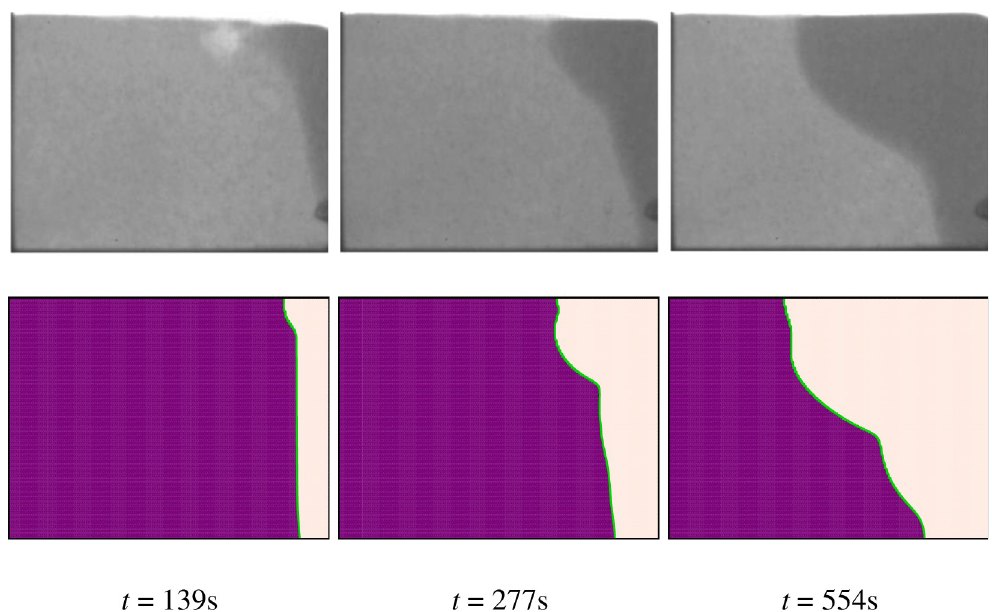
Fig 5. The comparison of experimental and numerical results: First row experiments of Kumar et al. [56], and the second row: The present simulation.